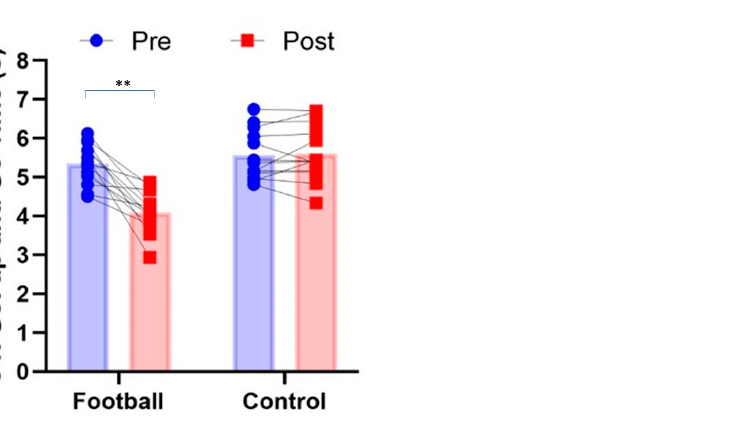
Figure 3. Group mean and individual time for 8-foot get up and go performance (s) before and after in recreational football for health intervention group and matched controls (** p < 0.01).